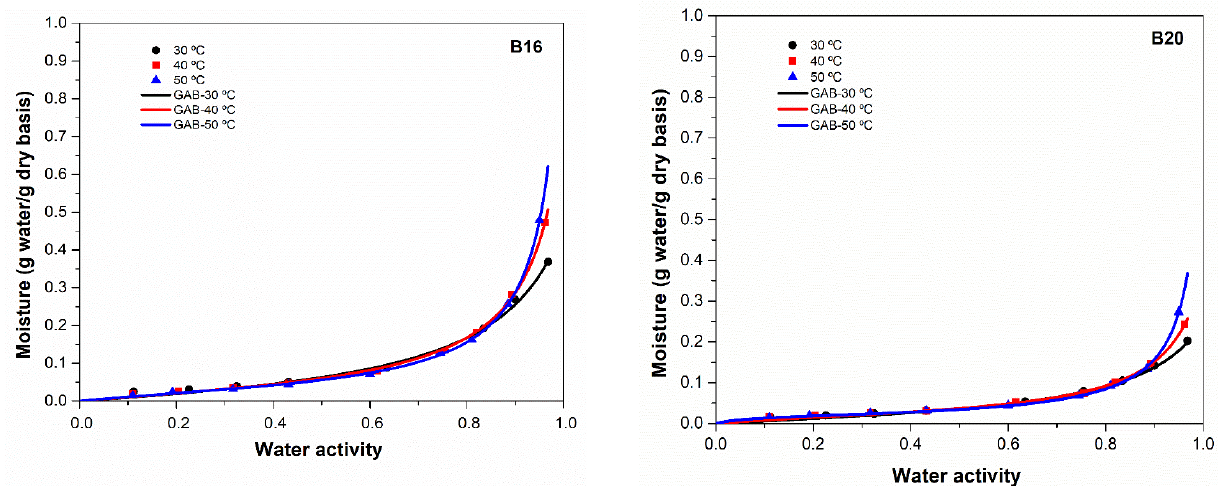
Figure 3. Experimental and estimated (Gab model) moisture adsorption data as a function of water activity and temperatures of 30, 40, and 50 °C.